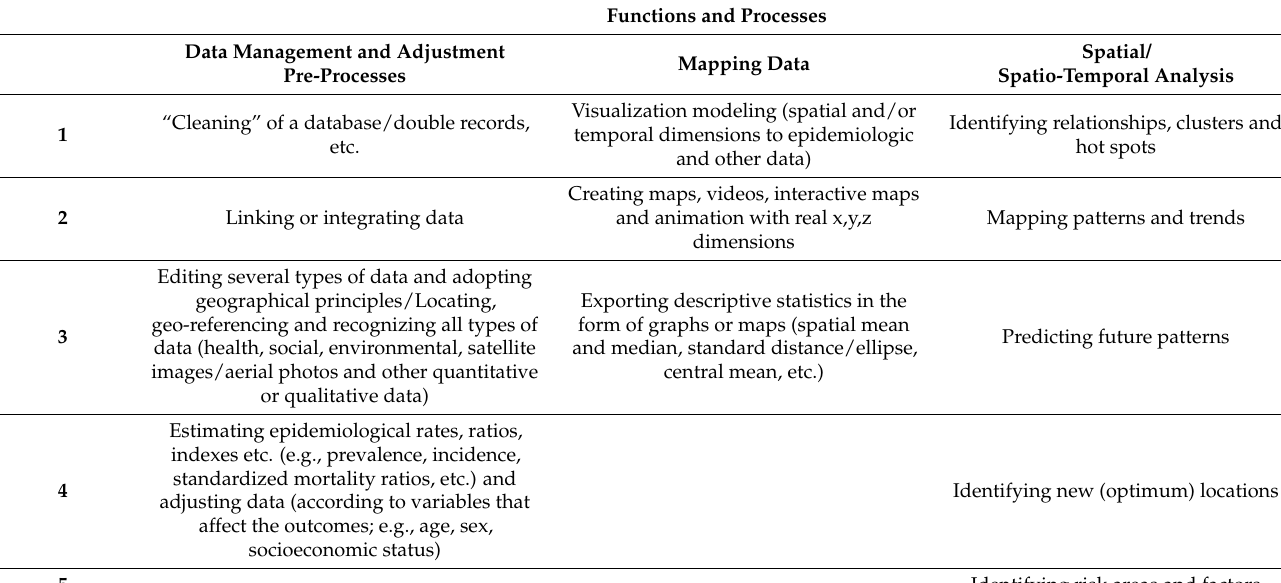
Table 2. Main functions and processes of the